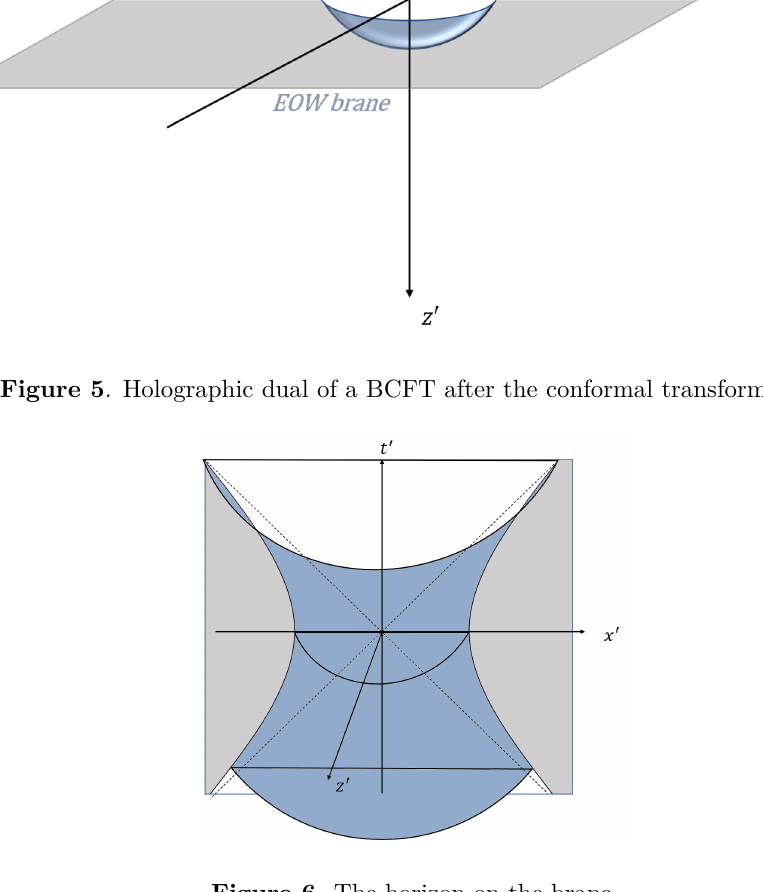
Figure 6 . The horizon on the